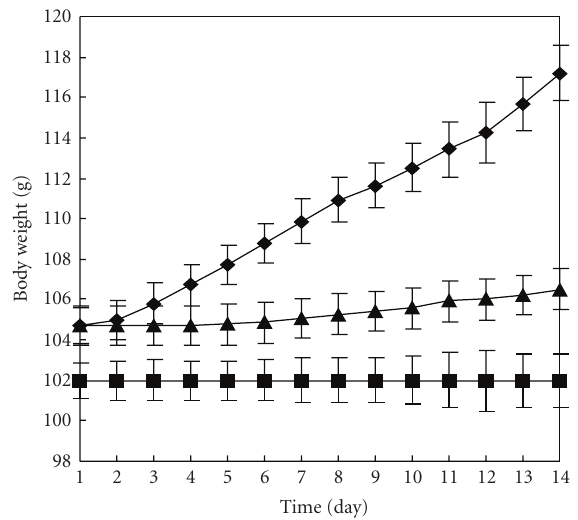
Figure 4: Growth curves of hypox rats. Hypox rats were gavaged with BmrhGH at the dose of 4.5 mg/rat.day in silkworm pupae protein sample ( ). In the control group, hypox rats were gavaged with protein sample from silkworm pupae infected by WT BmNPV at the same dose ( ). The hypox rats of third group were gavaged with 0.9% NaCl solution as blank ( ).